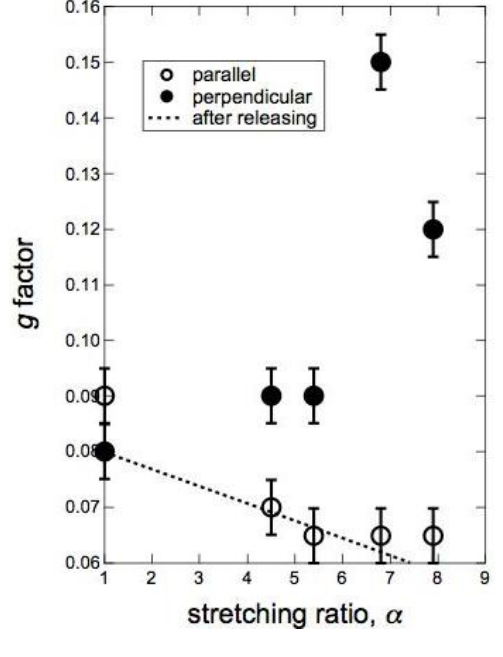
Figure 7. Variation of the g -factor as a function of the stretching ratio (  ), evaluated from the model fitting of the SAXS profiles shown in Figures 5 and 6. To compare with the previous results plotted in Figure 3, the approximated line for those data is shown by the dotted